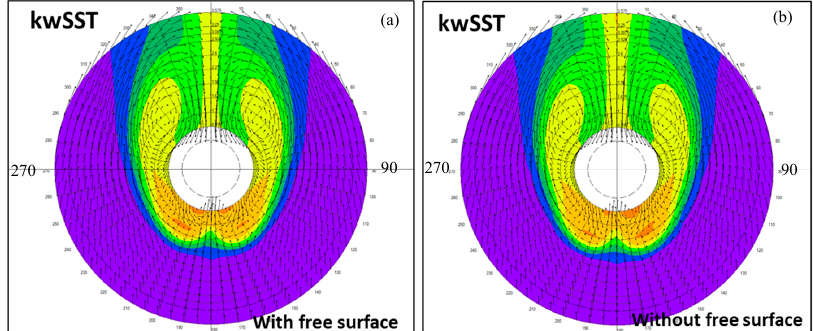
Figure 5. Nominal wake field on the propeller plane, ( a ) computed with and ( b ) without a free surface. (Full scale, Vs = 14 kn, w/o ESD). (same color scale as in Figure 4).